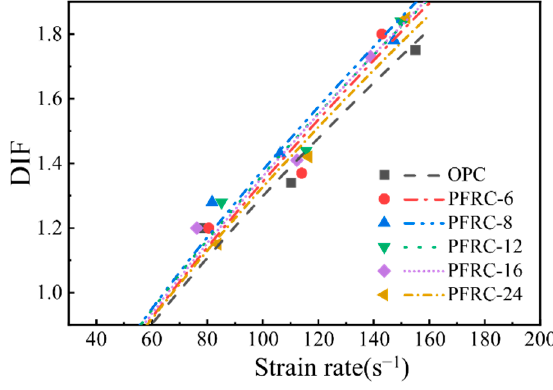
Figure 11. Empirical DIF relations for OPC and PFRC.